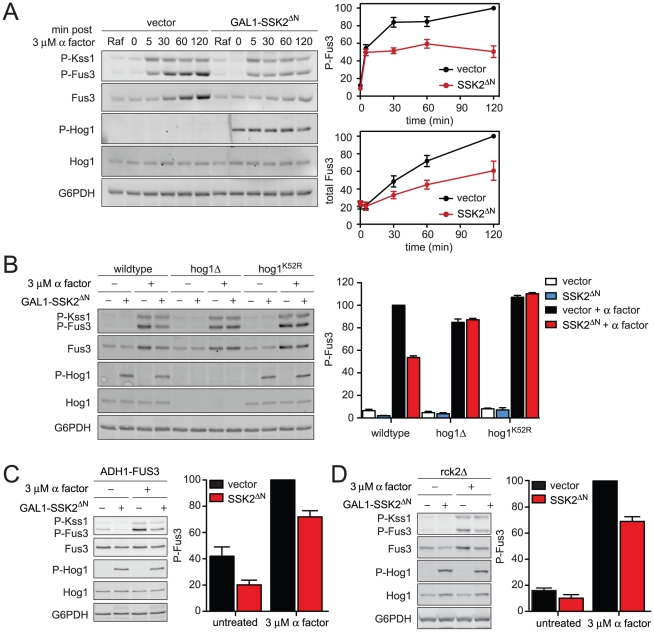
Constitutively active Hog1 dampens Fus3 activation and induction.(A) Activation kinetics of Fus3 with constitutively active Hog1; wild-type cells transformed with vector control or plasmid-borne GAL1-SSK2ΔN were grown in SC media with 2% raffinose (Raf). Ssk2ΔN expression was induced by addition of 2% galactose for 60 min followed by addition of 3 µM α factor for 30 min. Cell lysates were resolved by 12.5% SDS-PAGE. P-Fus3 and P-Kss1 were detected with phospho-p44/p42 antibodies. P-Hog1 was detected with phospho-p38 antibodies. Total Fus3 and Hog1 were detected with Fus3 and Hog1 antibodies. G6PDH served as a loading control. All primary antibodies were recognized by fluorescently labeled secondary antibody, detected by fluorescence scanner (Typhoon Trio) and quantified by scanning densitometry (ImageJ). The panels to the right show averaged scanning densitometry of four individual experiments. Error bars represent ± SEM. P-Hog1 reduced P-Fus3 by 49.4%±6.7% at 120 min. (B) Wild-type, hog1Δ, and, hog1K52R cells transformed with GAL1-SSK2ΔN or parent vector control were grown in SC and 2% galactose for 60 min followed by addition of 3 µM α factor or left untreated for 30 min. (C) fus3Δ cells transformed with ADH1-FUS3 and GAL1-SSK2ΔN or vector were grown and stimulated as in B. P-Hog1 (SSK2ΔN) reduced P-Fus3 by 30.7%±3.2%. (D) rck2Δ cells transformed with GAL1-SSK2ΔN or vector were grown and stimulated as in B. P-Hog1 reduced P-Fus3 by 31.0%±6.2%.